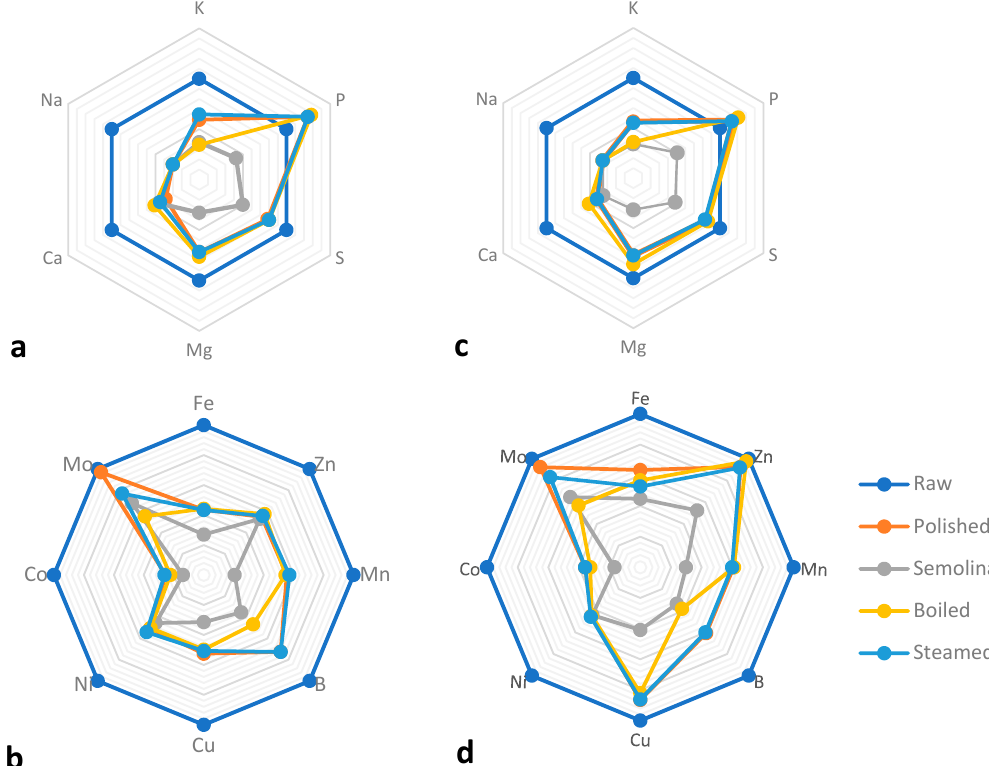
Figure 3. Macro and micro-minerals as % of their concentrations in raw seeds. With ( a , b ) for Puno and ( c , d ) for cv